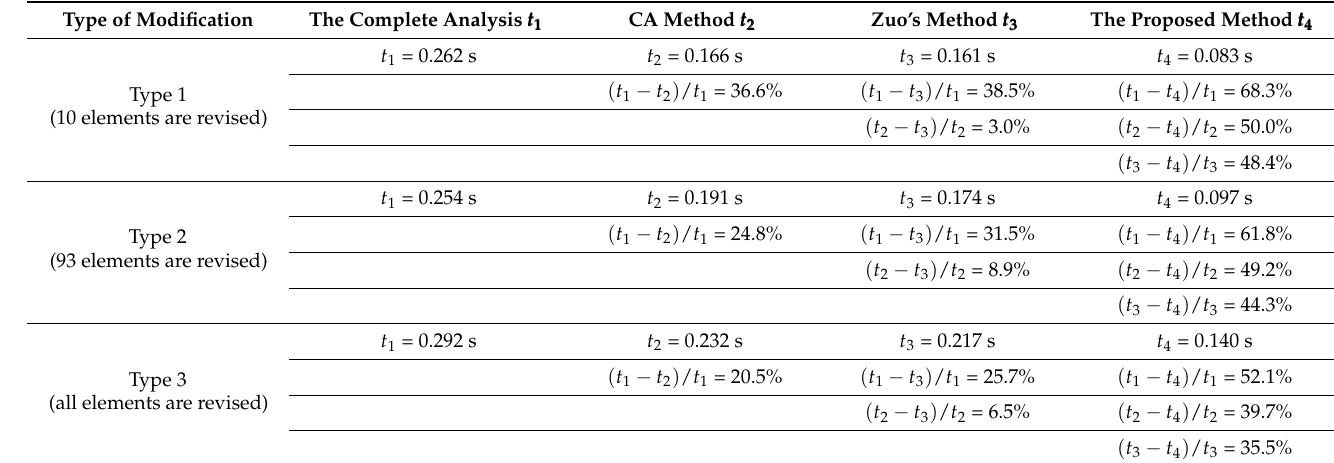
Table 5. Computation times of the four algorithms for the three types of modifications.